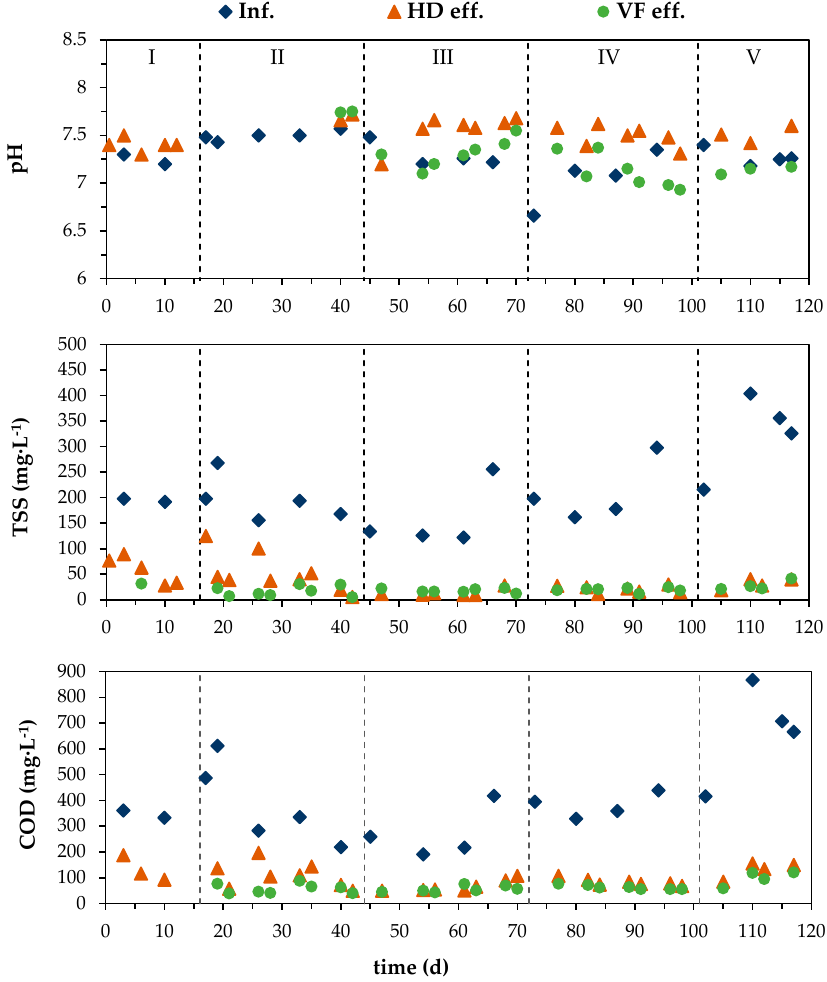
Figure 2. Evolution of several operational parameters in the raw influent and effluent of HD and VF units. Acronyms: TSS = total suspended solids; COD = chemical oxygen demand; Inf = municipal wastewater influent; HD eff = hybrid digester effluent; VF eff = vertical flow constructed wetland